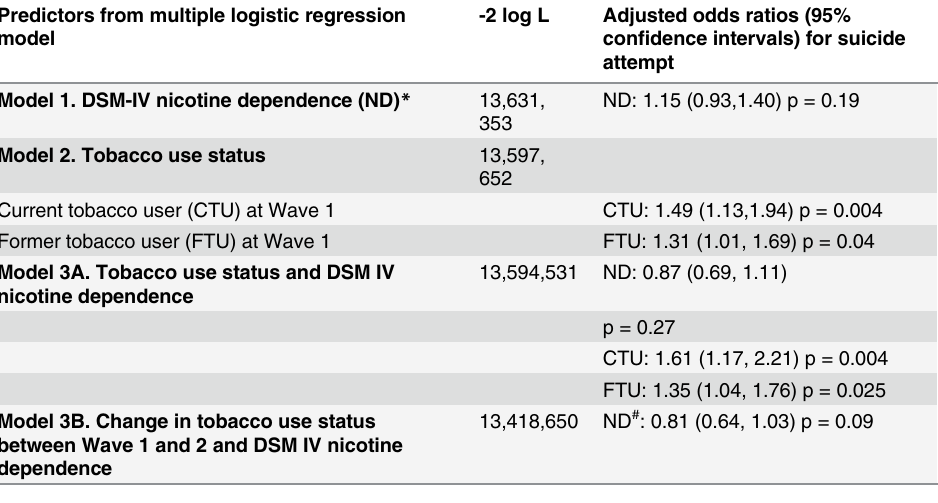
Table 3. Comparison of lifetime nicotine dependence and different tobacco use variables in the multi- ple logistic regression models predicting Wave 1 to Wave 2 suicide attempt. Predictors from multiple logistic regression